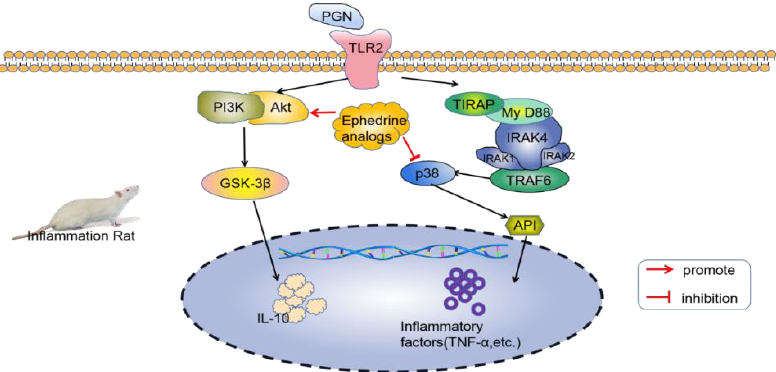
Figure 3. Mechanism through which Ephedra inhibits inflammatory factors in mice with peritonitis.